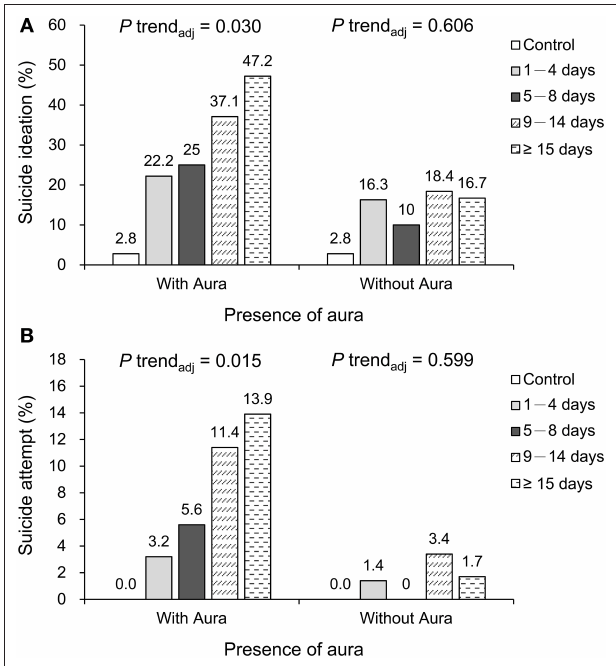
FIGURE 1 | Prevalence of suicidal ideation (A) and attempted suicide (B) across the study groups, including patients with and without auras.